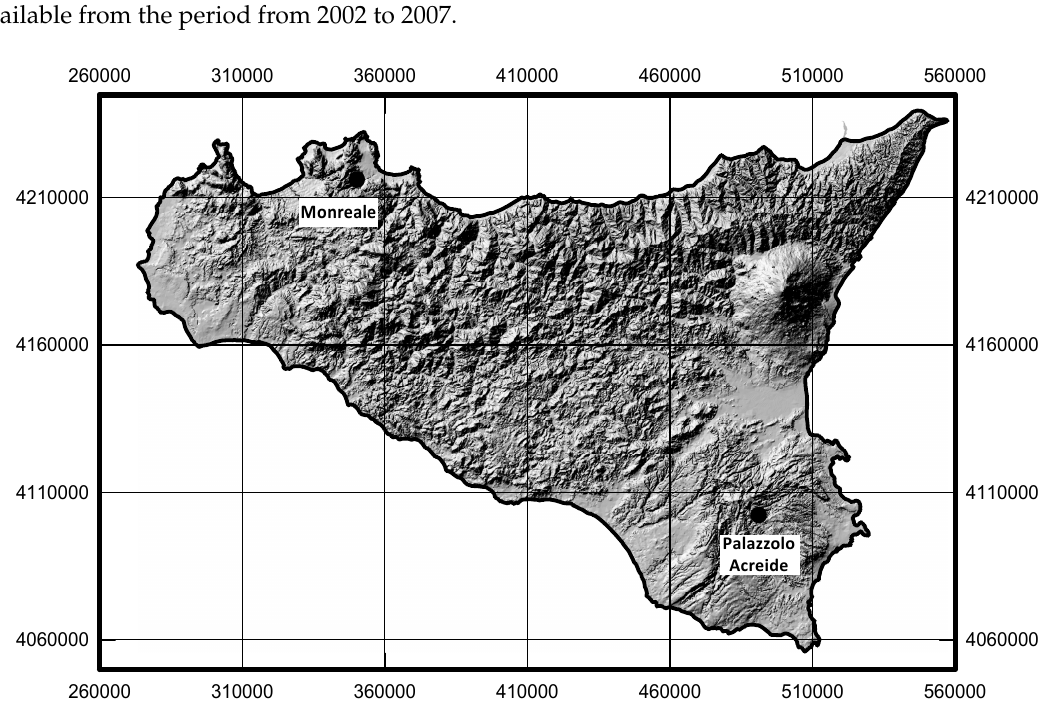
Figure 1. Location of the rain gauge stations used for the study.